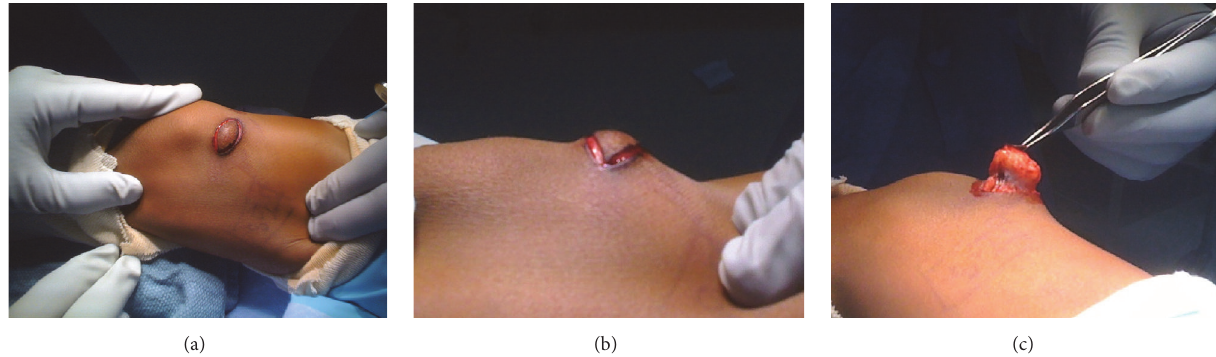
Figure 2: Intraoperative imagining demonstrates the mass within the subcutaneous tissue in the anteromedial region of the distal femur (a). An elliptical incision was made (b) and the calcified mass was carefully dissected and removed (c).